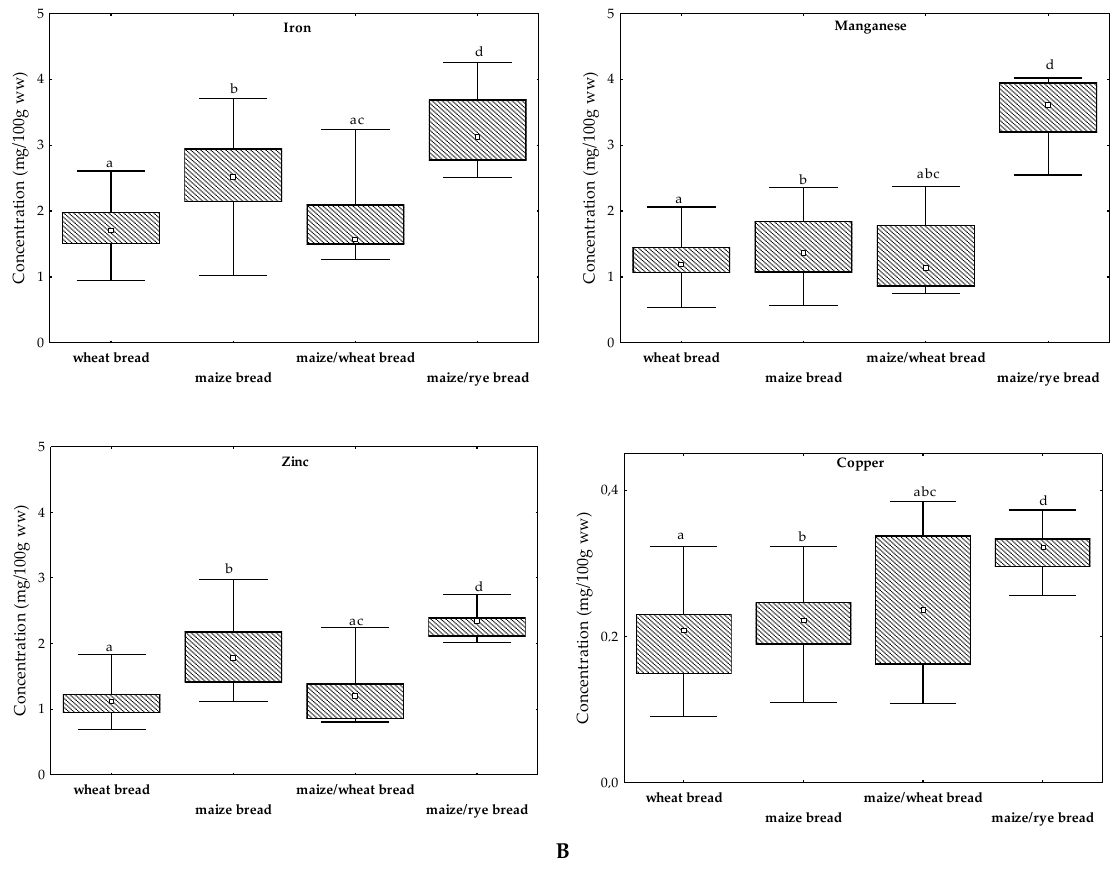
wheat bread maize/wheat bread wheat bread maize/wheat bread maize bread maize/rye bread maize bread maize/rye bread B Figure 1. Concentrations ( □ Median, 25–75% and range, mg/100 g ww) of ( A ) Figure 1. Concentrations ( (cid:3) Median, Figure 1. Concentrations ( □ Median, 25–75% and range, mg/100 g ww) of ( A ) range, mg / 100 g ww) of ( A ) macroelements Figure 1. Concentrations (□ Median, 25 – 75% and range, mg/100 g ww) of ( A ) macroelements and ( B ) microelements in breads. Each le tt er (a − d) corresponds to a type of bread (a, macroelements and ( B ) microelements in breads. Each le tt er (a − d) corresponds to a type of bread (a, and ( B ) microelements in breads. Each letter (a − d) corresponds to a type of bread (a, wheat bread; macroelements and ( B ) microelements in breads. Each letter (a−d) corresponds to a type of bread (a, b, maize bread; c, maize / wheat bread; d, maize / rye bread). The same letter in a box plot indicates wheat bread; b, maize bread; c, maize/wheat bread; d, maize/rye bread). The same letter in a box plot wheat bread; b, maize bread; c, maize/wheat bread; d, maize/rye bread). The same letter in a box plot wheat bread; b, maize bread; c, maize/wheat bread; d, maize/rye bread). The same letter in a box plot indicates that the given medians are not statistically different ( p > 0.05). indicates that the given medians are not statistically different ( p > 0.05). indicates that the given medians are not statistically different ( p > 0.05).